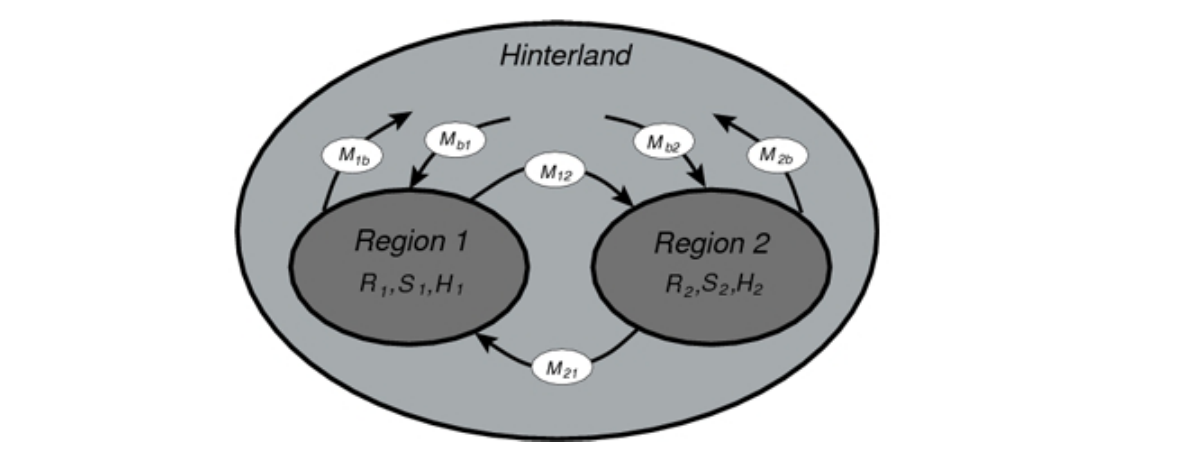
Fig. 2 . Schematic of the two patch